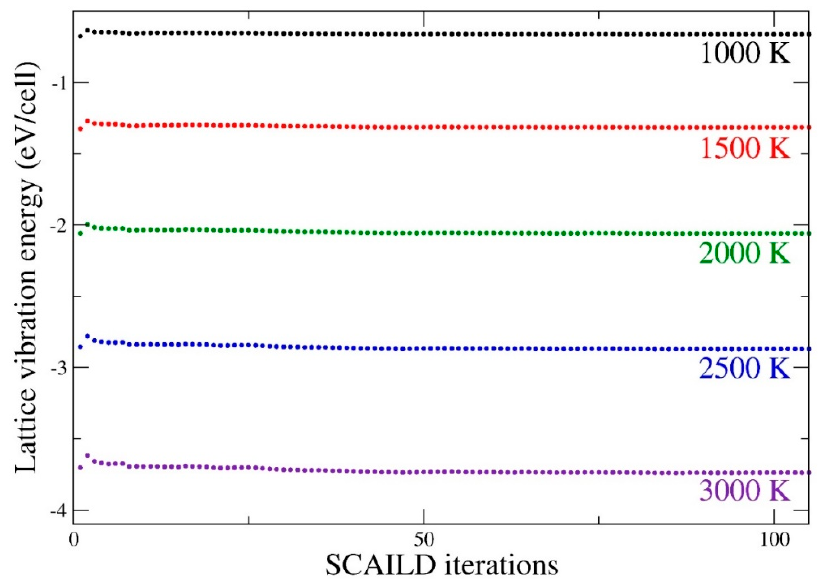
Figure 1. Self-Consistent Ab Initio Lattice Dynamics (SCAILD) lattice vibration energies for five temperatures, at constant atomic volume (14.85 Å 3 ), as functions of number of SCAILD iterations.